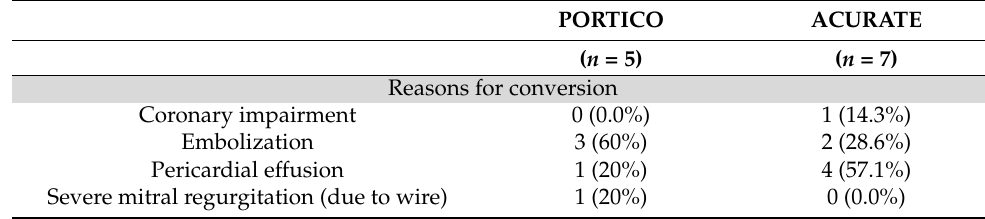
Table 4. Reasons for conversion to open heart surgery (entire population).